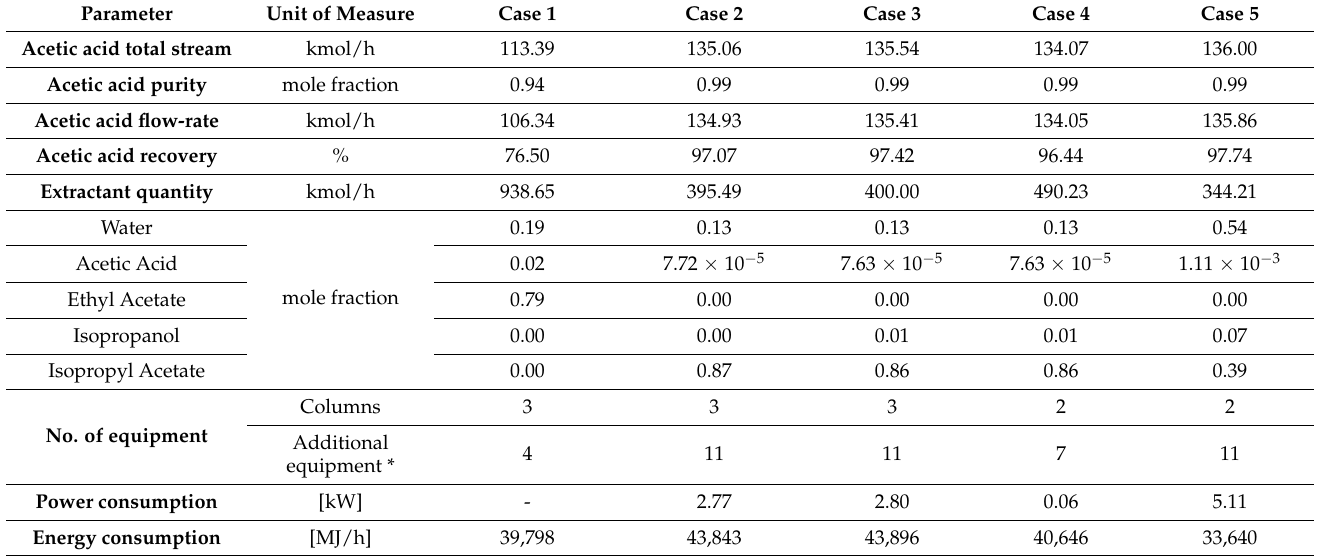
Table 8. Comparison between the three five cases regarding key characteristics of the